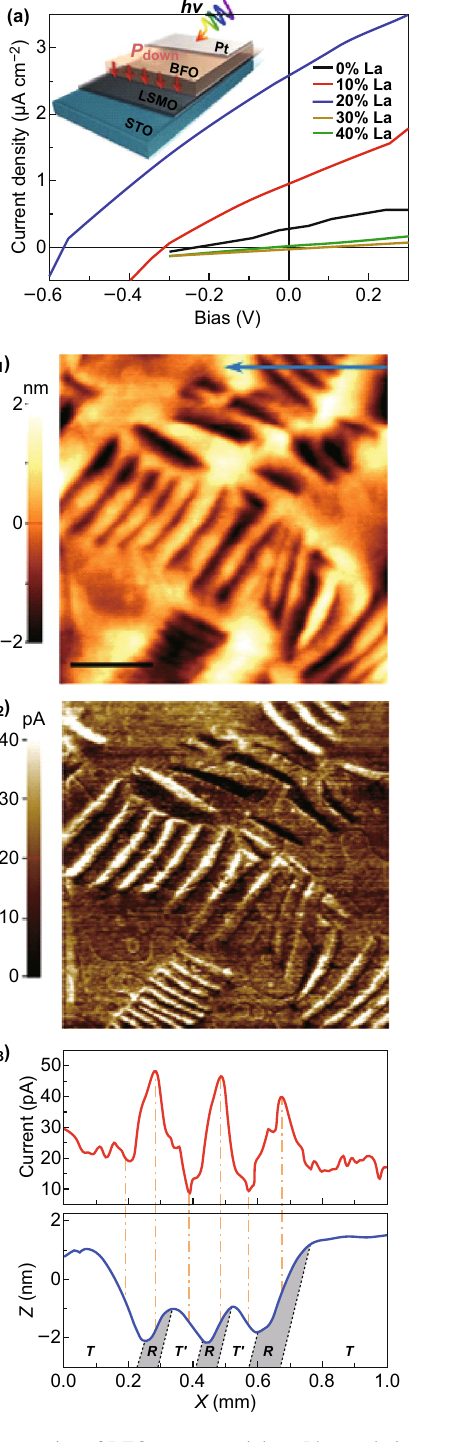
Fig. 5 Optical properties of BFO nanomaterials. a Photovoltaic responses of the La‑substituted BFO films. Adapted with permission from Ref. [113]. b Current density for both the BFO and Mn‑doped BFO films. Adapted with permission from Ref. [64]. c Photocurrent distribution of BFO film. c 1 Surface topography and c 2 photocurrent distribution characterized under illumination. c 3 Profile comparison between the photo‑ current and surface morphology of the area marked by blue arrow in c 1 . Adapted with permission from Ref. [114]. d The photocurrent under different light intensities in heating and cooling states. Adapted with permission from Ref. [21]. e Output current as a function of temperature. Adapted with permission from Ref. [115]. f BFO nanomaterials with different morphologies show different photocatalytic activities. Adapted with permission from Ref. [40]. (Color figure